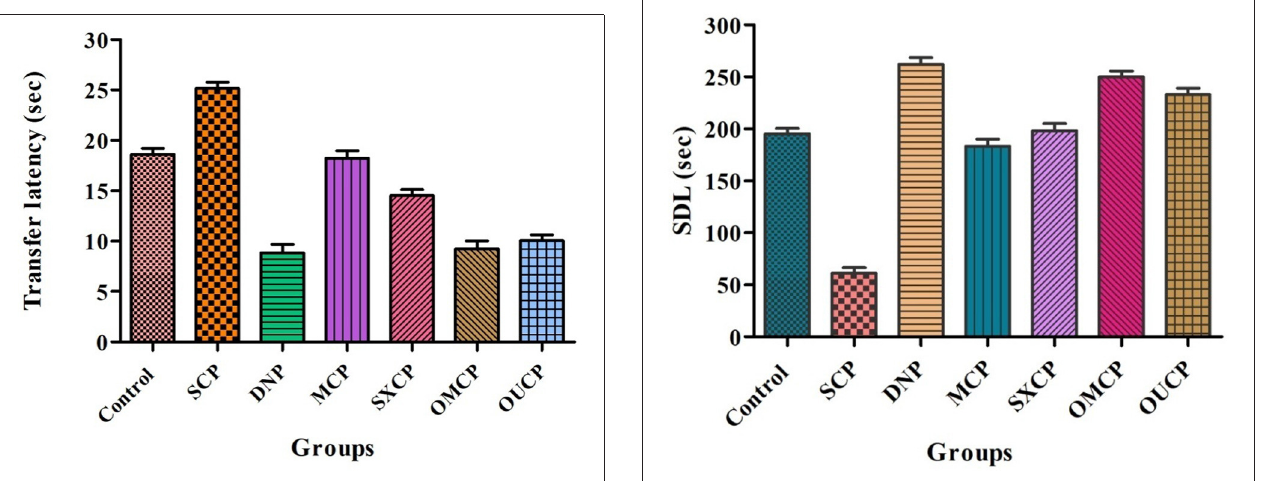
Frontiers in Nutrition |